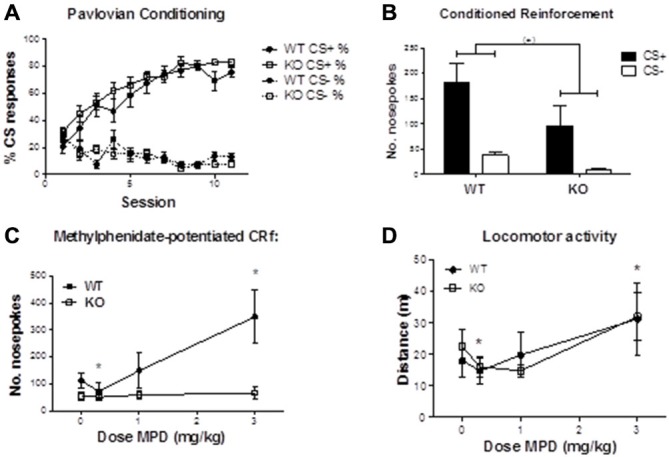
(A) Percentage of CS presentations resulting in entry to the food magazine following presentations of CS+ or CS−, over successive training sessions. There were no statistically significant differences in the rate at which WT and α2−/− mice acquired the association between CS+ and food delivery (nosepoke by genotype interaction: F(1,22) = 1.322, p = 0.263). (B) Numbers of head entries into nose-poke detectors resulting in 1-s presentations of either the CS+ or CS−. Although WT mice showed a tendency to make more nosepokes into either CS+ or CS− holes (F(1,22) = 4.170, p = 0.053), there were no significant interactions between genotype and CS, or in responding for the CS+. (C) After methylphenidate treatment, mice showed a dose dependent change in nosepoke responding that differed according to genotype (nosepoke * dose *genotype interaction: F3,51 = 4.276, p < 0.01). This effect was attributable to CS+ responses (dose*genotype interaction: F3,51 = 4.336, p < 0.01) but not the CS− (dose*genotype interaction: F3.51 = 1.015, p = 0.394). The dose dependent effect of responding on the CS+ was evident in WT (F3,30 = 7.286, p < 0.01) but not in the α2−/− mice (main effect of dose: F3,21 = 0.127, p = 0.943). * indicates significant differences from the vehicle condition in WT mice. (D) Methylphenidate increased locomotor activity in a dose-dependent manner (F3,66 = 7.825, p < 0.001), independently of genotype. * indicates significant differences from the vehicle condition. MPD (Methylphenidate).